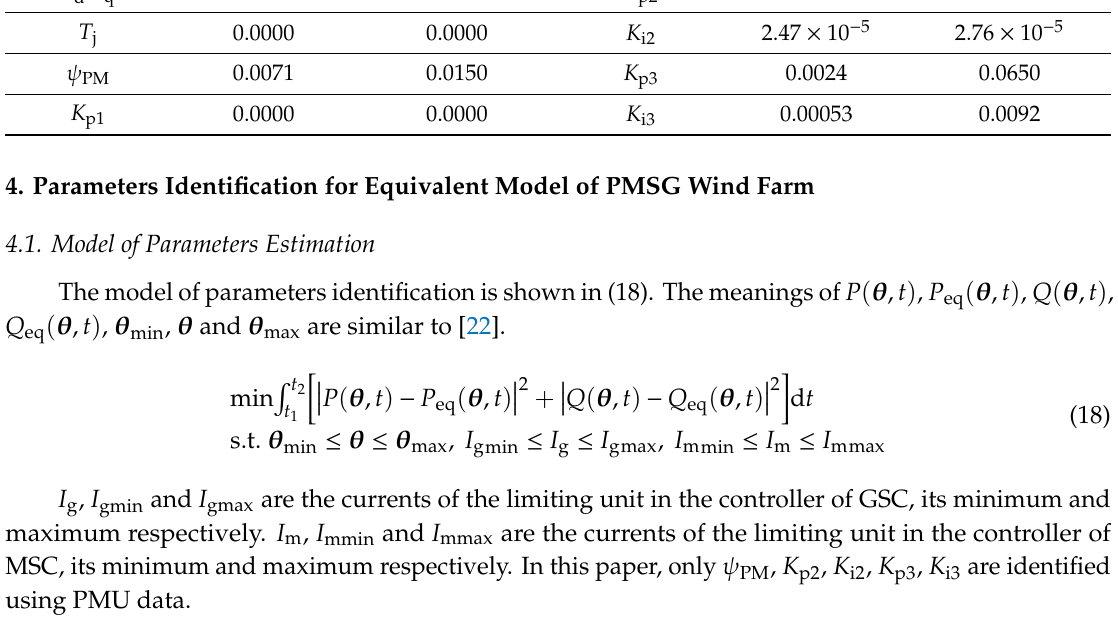
Figure 3. Trajectory sensitivity of reactive power when voltage dips about 30%: ( a )Trajectory sensitivity of reactive power for R s and ψ PM ; ( b ) Trajectory sensitivity of active power for K p2 , K i2 , K p3 and K i3 .